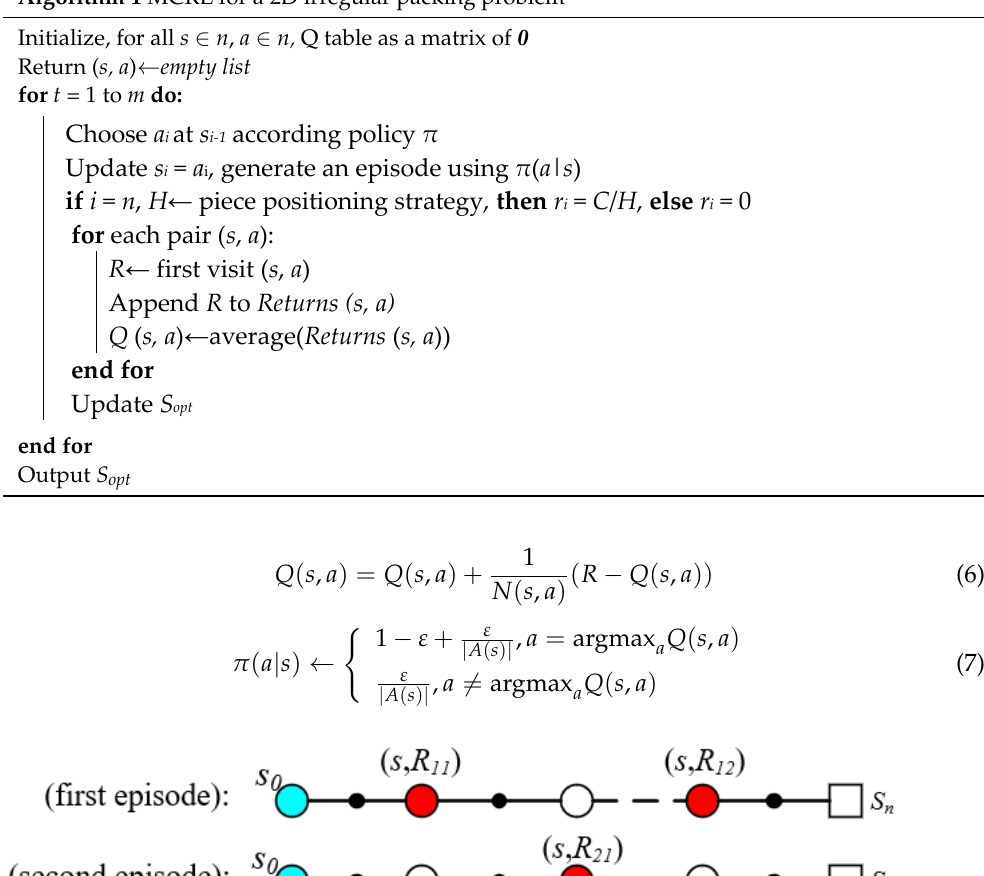
Figure 5. Markov decision-making process for the n -stage packing.